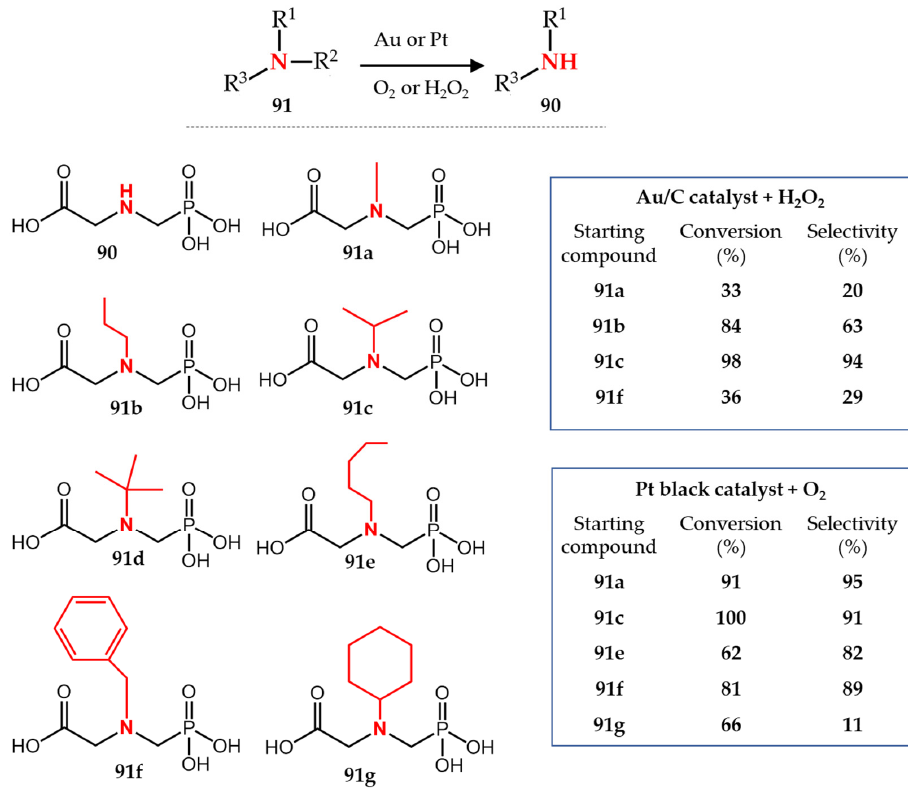
Figure 13. Glyphosate synthesis via Au ‐ or Pt ‐ catalyzed N ‐